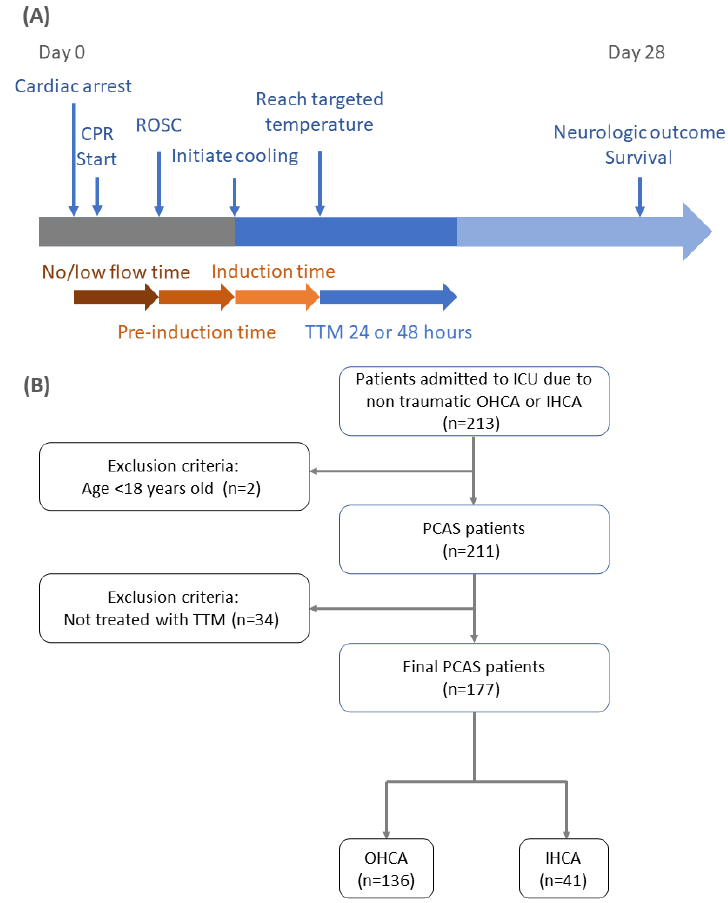
Figure 1. ( A ) Illustration of the time course from cardiac arrest to TTM. ( B ) Flowchart of patient inclusion and exclusion in the study. Abbreviations: CPR: cardiopulmonary resuscitation; ICU: intensive care unit; IHCA: in-hospital cardiac arrest; OHCA: out-of-hospital cardiac arrest; PCAS: post–cardiac arrest syndrome; ROSC: return of spontaneous circulation; TTM: targeted temperature management.